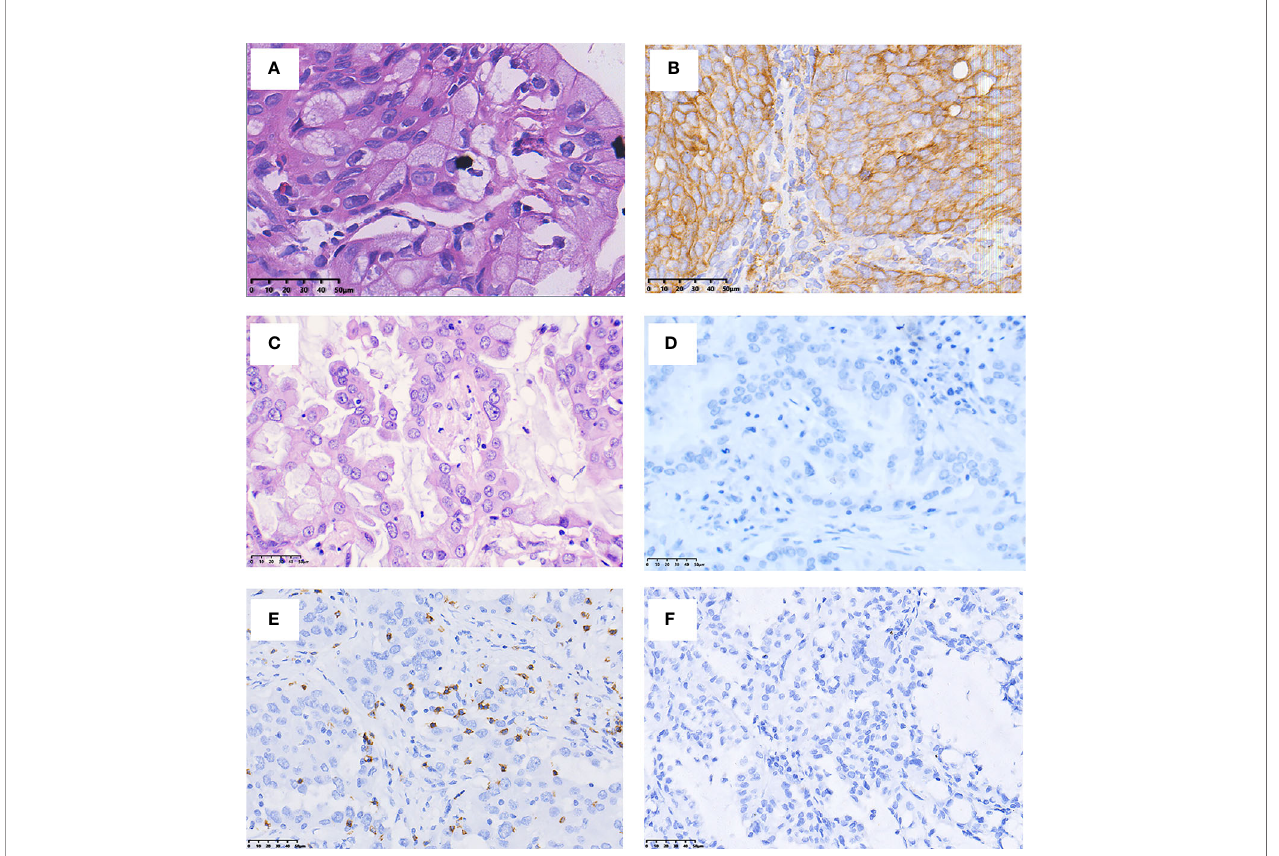
FIGURE 2 | Representative images of PD-L1 and CD8 immuno-staining (×400 original magni fi cation). H&E (A) and PD-L1 (B) staining of patients with PD-L1+; H&E (C) and PD-L1 (D) staining of patients with PD-L1 − ; (E) presence of CD8+ TILs; and (F) absence of CD8 +